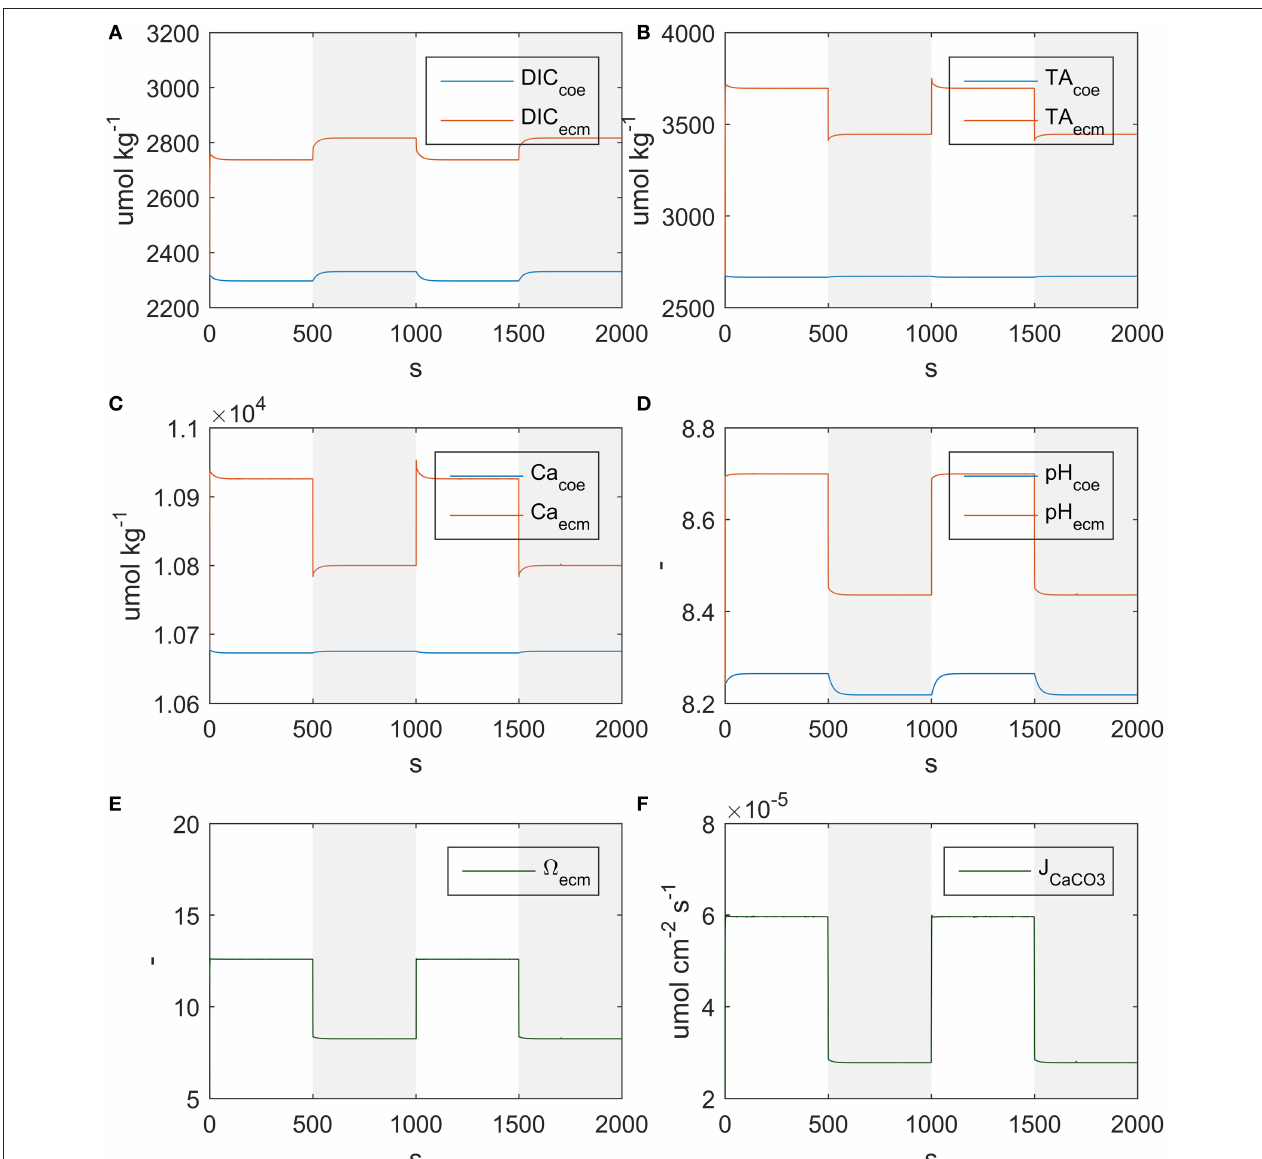
FIGURE 4 | State variables behavior under alternating light and dark conditions. Shaded regions indicate dark conditions. (A) DIC, (B) TA, (C) Ca 2 + , (D) pH, (E) aragonite saturation, (F) Calcification rate.